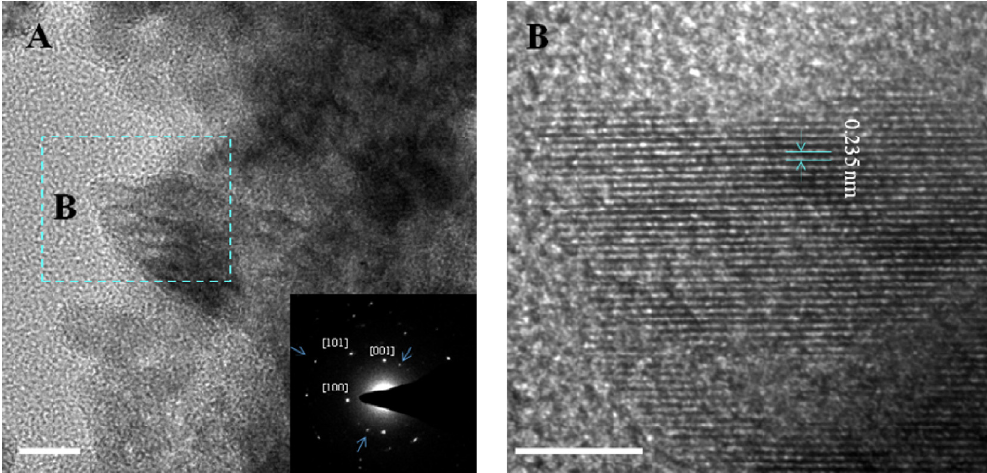
Fig. 2. (A) Low resolution, and (B) high resolution transmission electron microscope images of TiO 2 nanorice. The low resolution image verify nanorice morphology, and as well as SAED analysis (see inset in (A)), showing that nanorice are mono-crystalline. The high resolution image shows fringe spacing of 0.23 nm, reveals high exposure facet (001) with its growth along the [001] direction. Scale bars 10 nm in (A), and 5 nm in